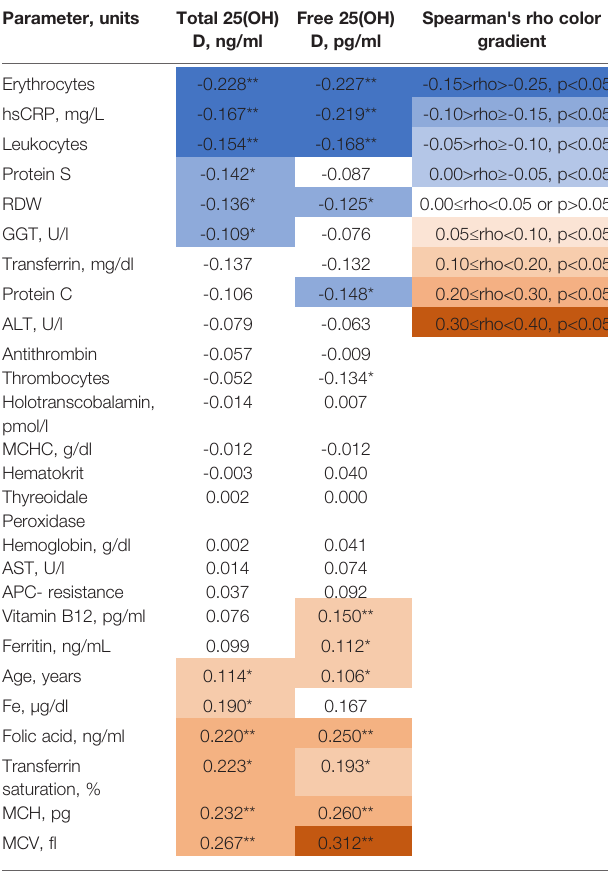
TABLE 3 | Bivariate correlations between total and free 25(OH)D and hematological and biochemical parameters sorted in ascending order according to according to spearman ’ s rank correlation coef fi cient (rho) for total 25(OH)D in 351 healthy women (women without any abnormal laboratory parameter). Parameter,